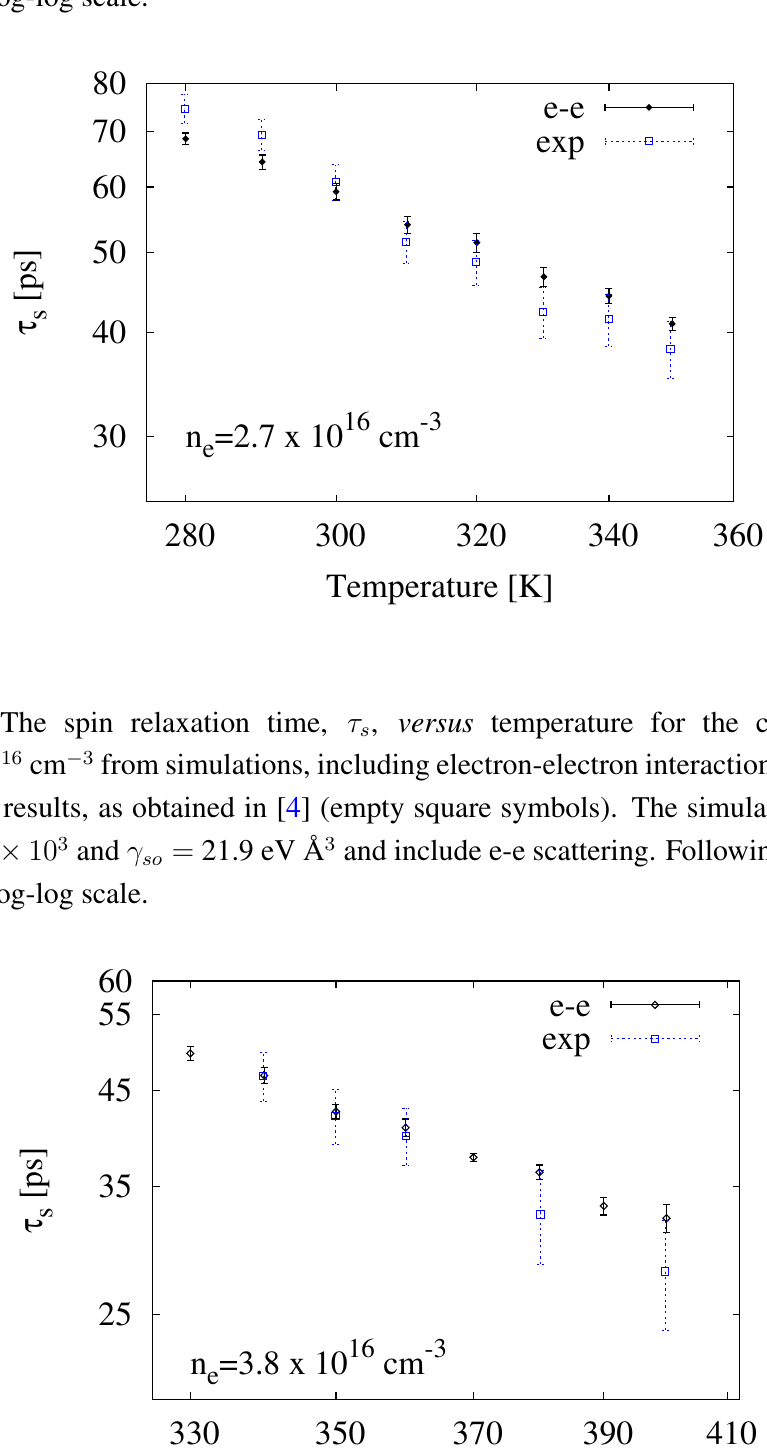
Figure 6. The spin relaxation time, τ , versus temperature for the carrier density s n = 2 . 7 × 10 16 cm − 3 from simulations, including electron-electron interaction, and from the e experimental results, as obtained in [4] (empty square symbols). The simulations are done = 21 . 9 eV ˚A 3 and include e-e scattering. Following [4], data are with N = 25 × 10 3 and γ so plotted on a log-log scale.